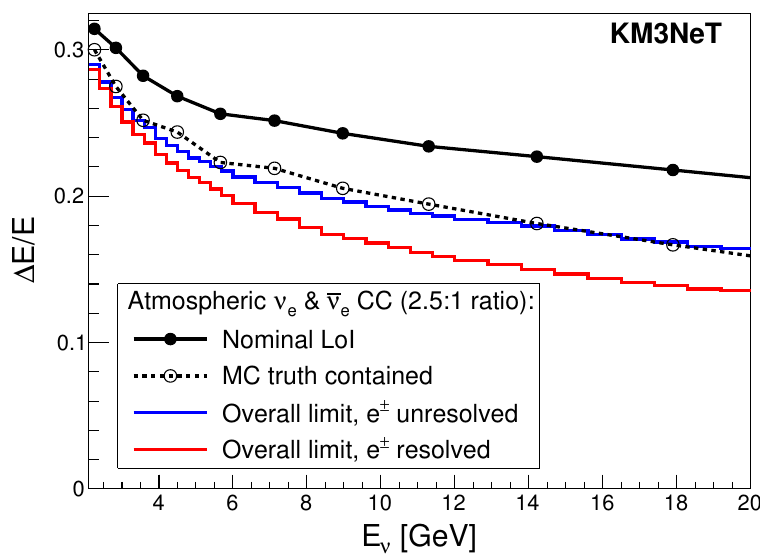
Figure 19 . Relative energy resolution (RMS) for KM3NeT/ORCA, calculated using a full detector simulation on atmospheric (cid:23) e and (cid:23) e CC events. Results are shown using both the event sample from ref. [2] (‘nominal LoI’), and one based on strict containment criteria on Monte Carlo truth neutrino interaction vertex and direction (‘MC truth contained’) [17]. This is compared to the overall limiting resolutions for (cid:23) e and (cid:23) e CC events (ratio 2 : 5:1) calculated here, both for the ‘ e